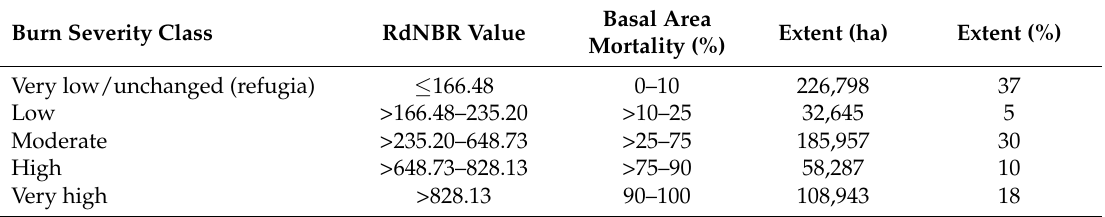
Table 4. RdNBR values, tree mortality ranges from forest inventory data, and extent of severity classes across study